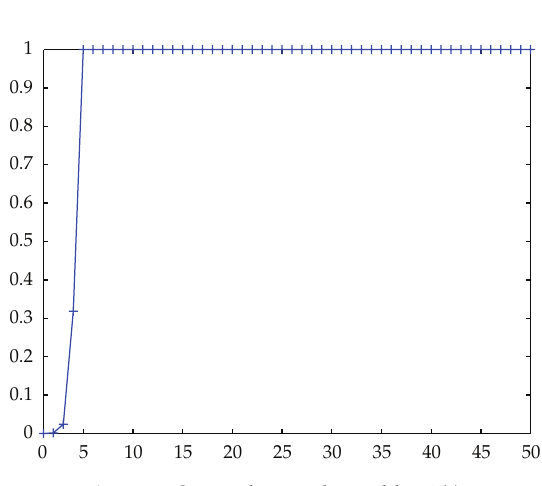
(cid:2) t (cid:3) 2